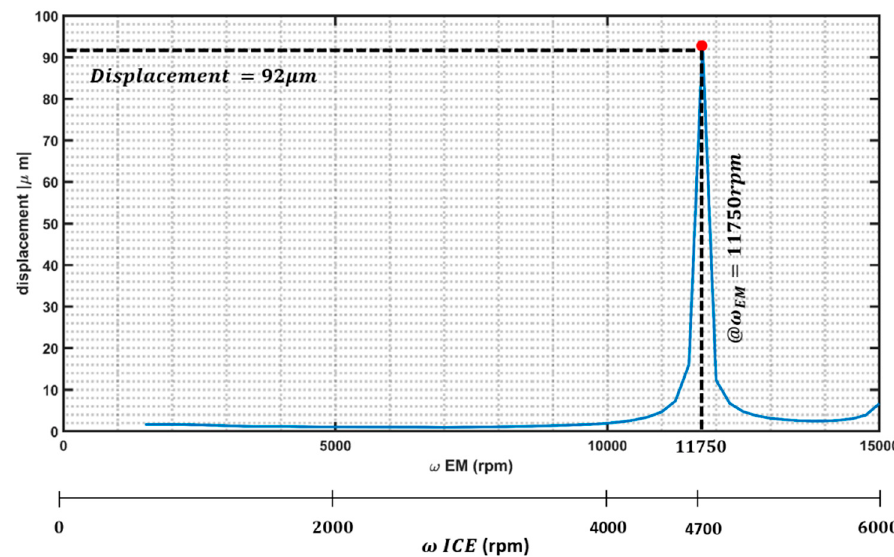
Figure 20. Displacement results for EM torque irregularities.